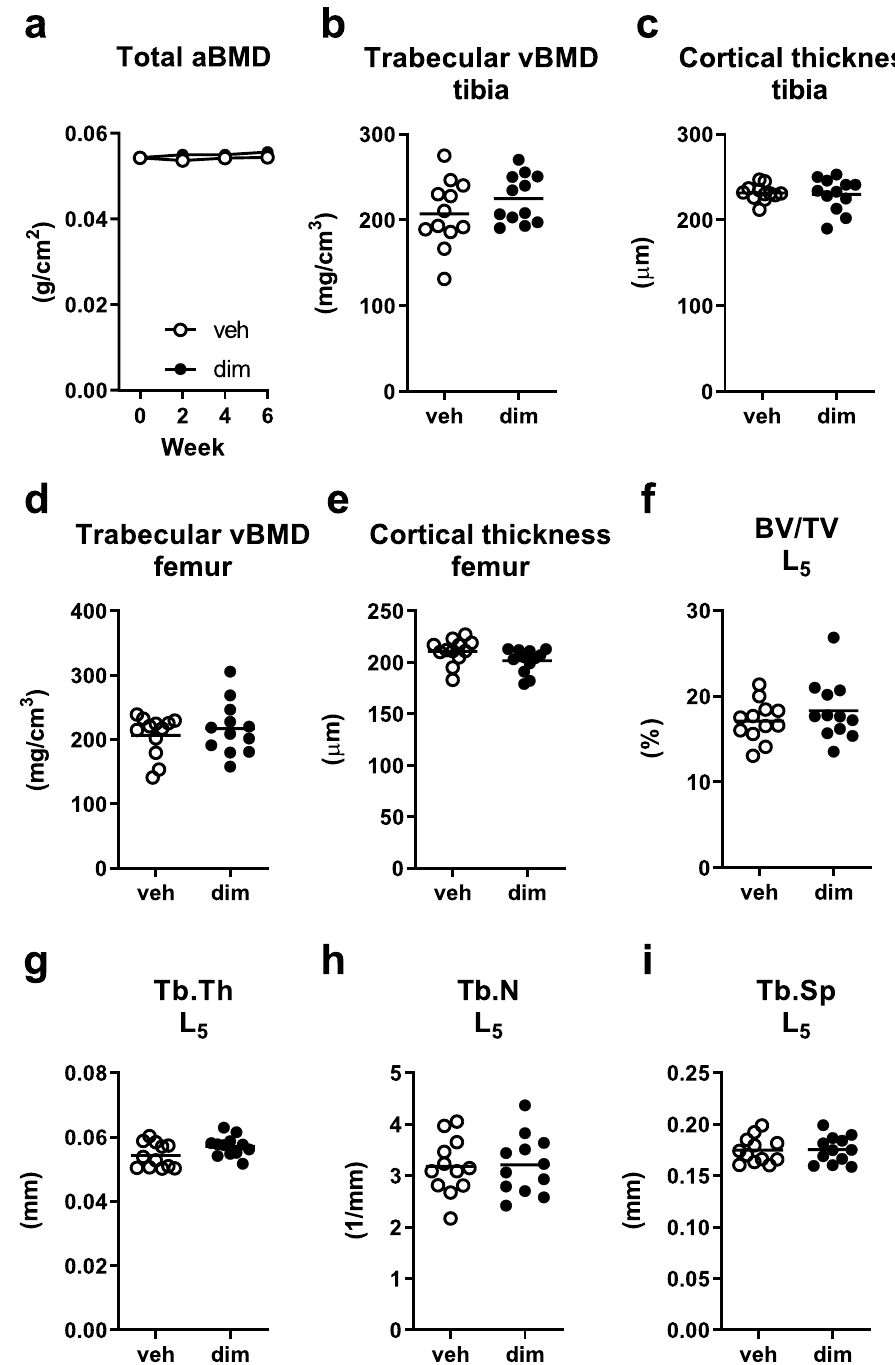
Figure 4. Long-term adipose tissue loss did not affect structural bone parameters. ( a ) Total areal bone mineral density (aBMD) measured by DXA at 0, 1, and 2 weeks after dimerizer injection. ( b ) Trabecular volumetric BMD (vBMD) of tibia, ( c ) cortical thickness of tibia, ( d ) trabecular vBMD of femur, and ( e ) cortical thickness of femur measured by pQCT 6 weeks after dimerizer injection. ( f ) Trabecular bone volume fraction (BV/TV), (g) trabecular thickness (Tb.Th), ( h ) trabecular number (Tb.N), ( i ) trabecular separation (Tb.Sp) of vertebra